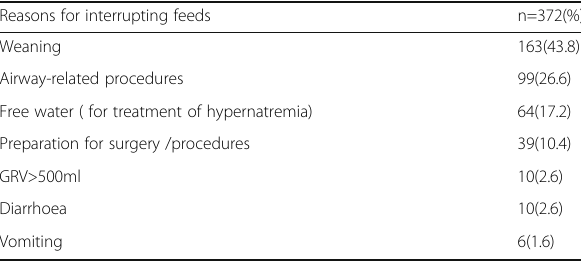
Table 30 (abstract A55). Reasons for interrupting